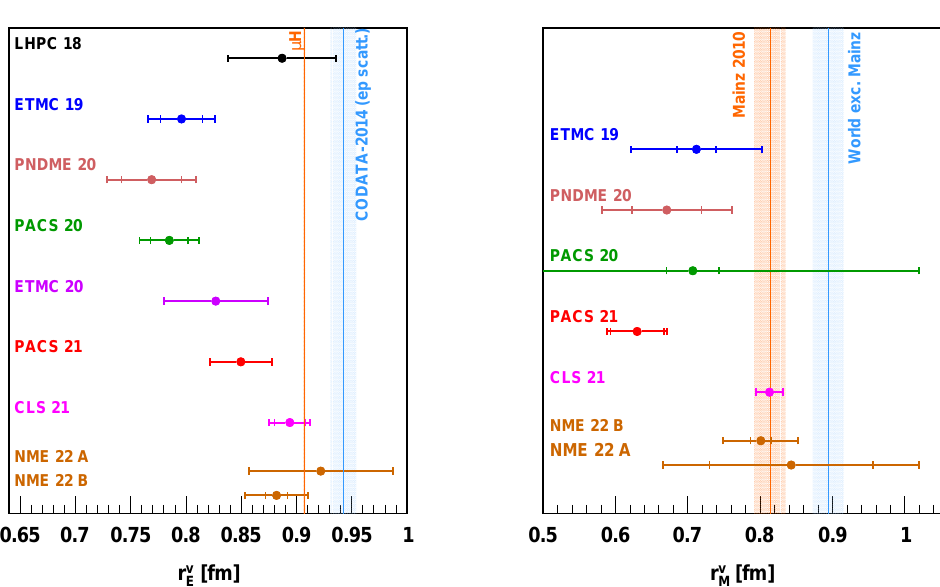
Figure 6. Left panel: the isovector charge radius from recent Lattice QCD calculations [46–53]. The vertical line and band in orange color are obtained based on the r p result from the muonic E hydrogen spectroscopic experiment [20] , and the blue vertical line and band are obtained based on the CODATA-2014 r p compilation [109]. Information about the neutron charge radius is obtained E from Particle Data Group (PDG) [110]. Right panel: the isovector magnetic radius from recent Lattice QCD calculations. The vertical line and band in orange color are obtained based on the r p result M from Lee et al. [38] for the Mainz 2010 data set, and the blue line and band are obtained based on the result from the same analysis, for the world data excluding the Mainz 2010 data set. Information about the neutron magnetic radius is obtained from PDG [110].